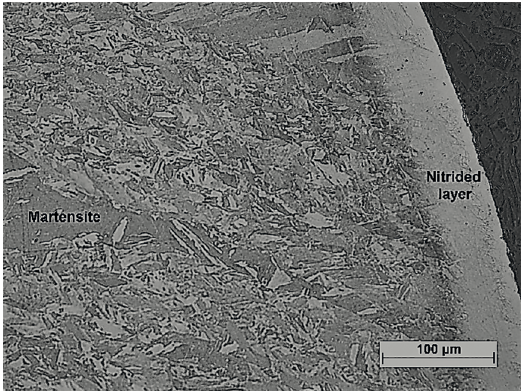
Figure 4: Three-dimensional AFM images (10.0 μm x 10.0 μm) of surface topography of (a) MAR-SA and (b) MAR-SAP.